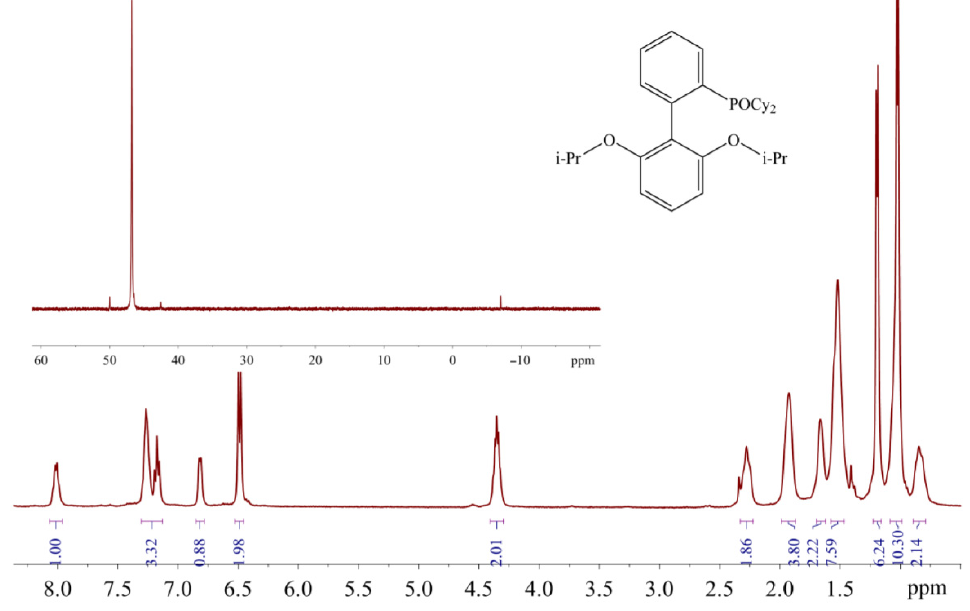
Figure 17. 1 H and 31 P (in the inset) NMR spectra of 5 in CDCl 3 .